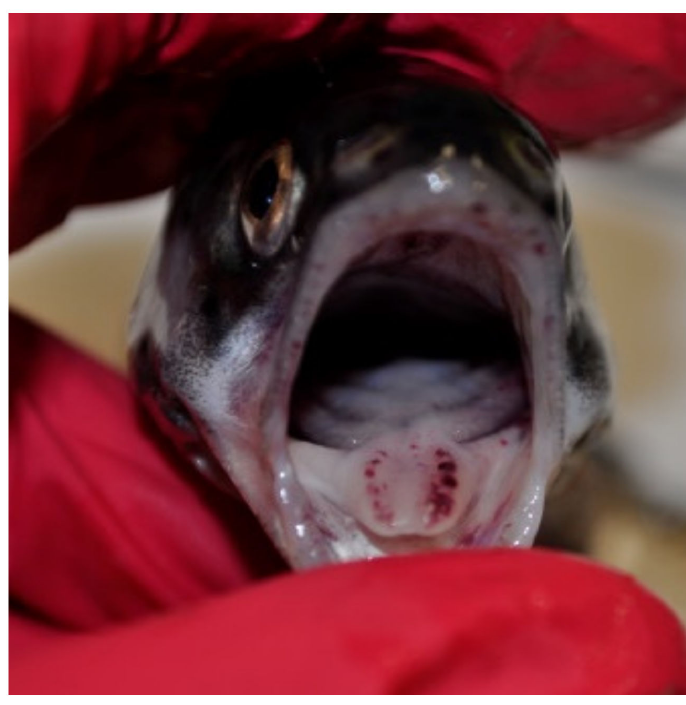
Figure 4. Petechiae visible on the tongue. After 72 h p.i., in the Yer and Yer+IPN groups, a decrease in the total protein level was found compared to the level before infection. This trend continued in the Yer+IPN group until the end of the experiment. On day 7 p.i., in the group infected with Y. ruckeri, the level of protein was significantly lower than in the other groups (Figure